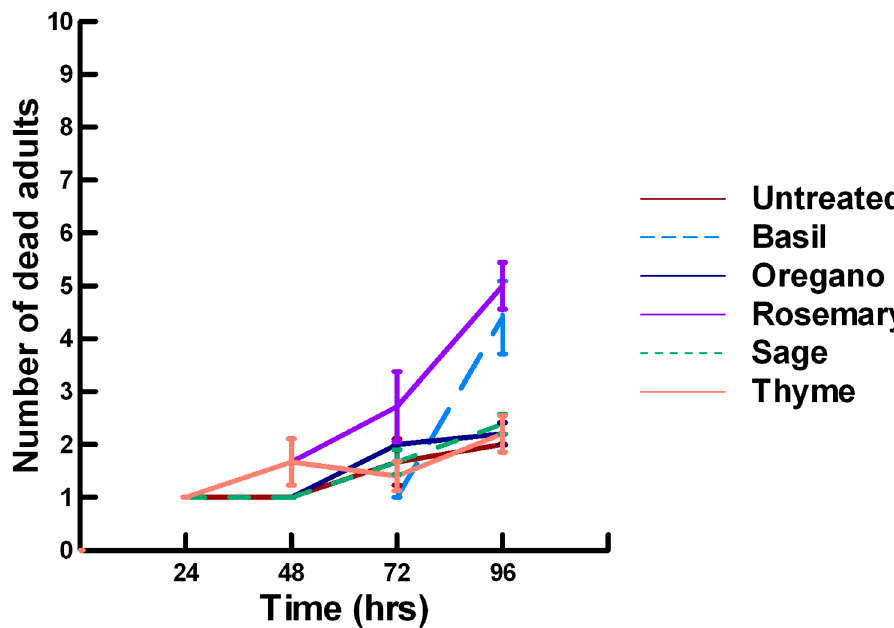
Figure 8. Acute contact toxicity with a low concentration of plant powders from the family Lamiaceae (basil, oregano, rosemary, sage and thyme) adherent to male adult Megachile rotundata (Alfalfa leafcutting bees; ALBs). Means and standard error shown.